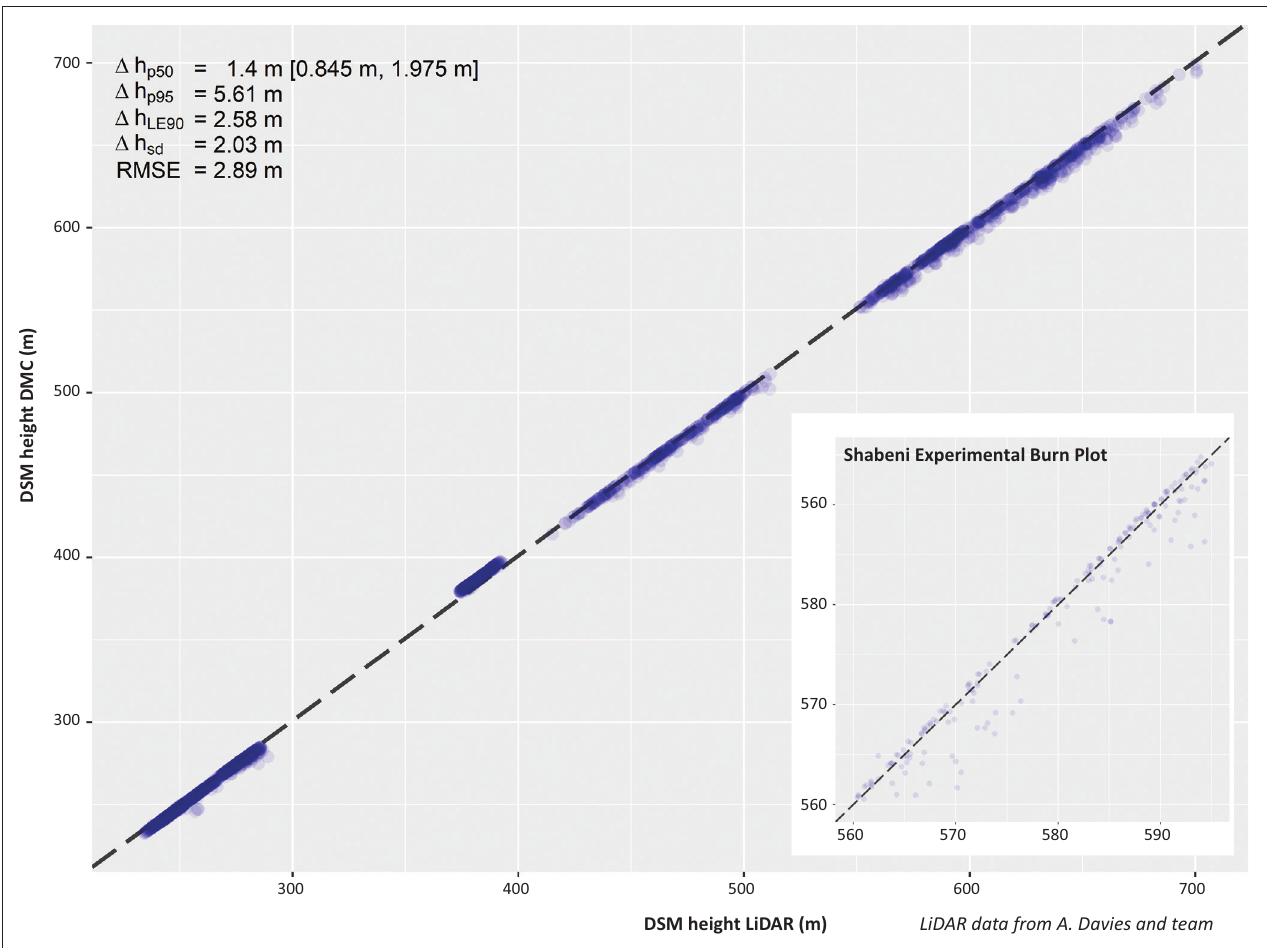
LiDAR data from A. Davies and team DSM height LiDAR (m) LiDAR, Light Detection and Ranging; DTM, digital terrain model; RMSE, root mean square error; DMC, Digital Mapping Camera. FIGURE 8: Validation of the modelled surface elevation (digital surface model) from stereoscopic aerial imagery with unmanned aerial vehicle-based lidar measurements for entire area and Shabeni Experimental Burn Plot sub-site. Seven different locations were used for the validation.